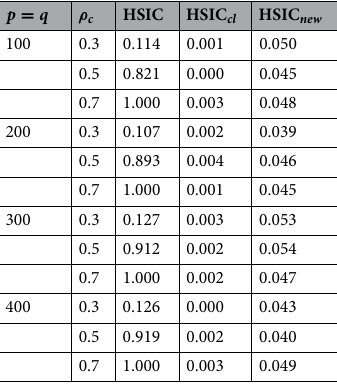
Table 3. Empirical size of the tests at 0.05 significance level under different dimensions ( p = q ) and within- cluster correlations (ρ c )